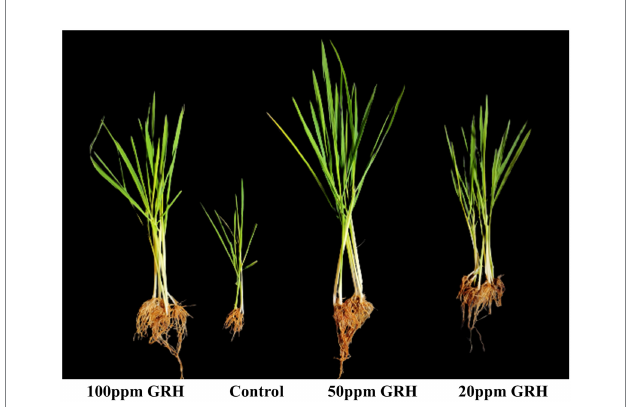
FIGURE 4 Phenotypes of rice seedlings Oryza sativa ssp. indica MTU 7093 Swarna under drought stress (induced by PEG treatment) sprayed with 20, 50, and 100 ppm EPS of Mucor sp. HELF2 endophyte.